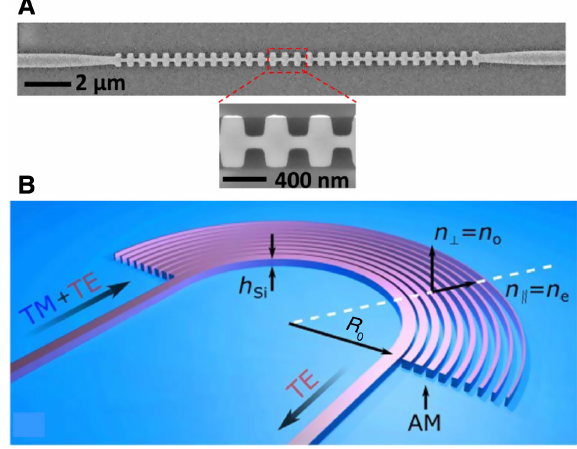
Figure 8: Schematic diagrams of the subwavelength structure–based